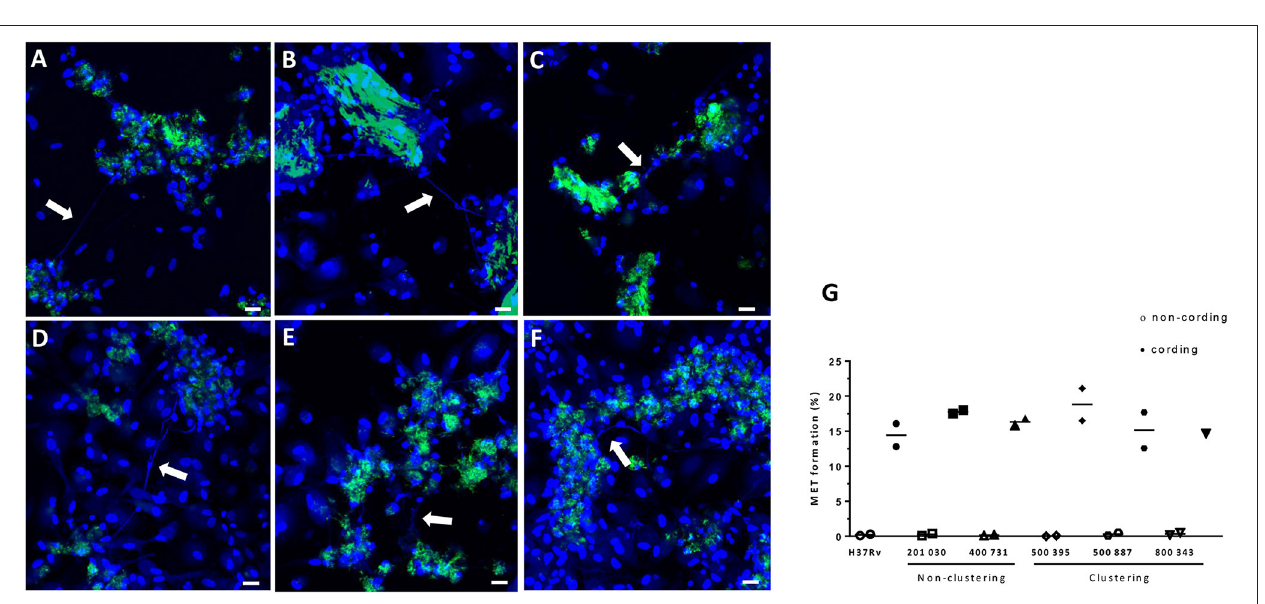
cord formation and the release of METs from hMDMs.